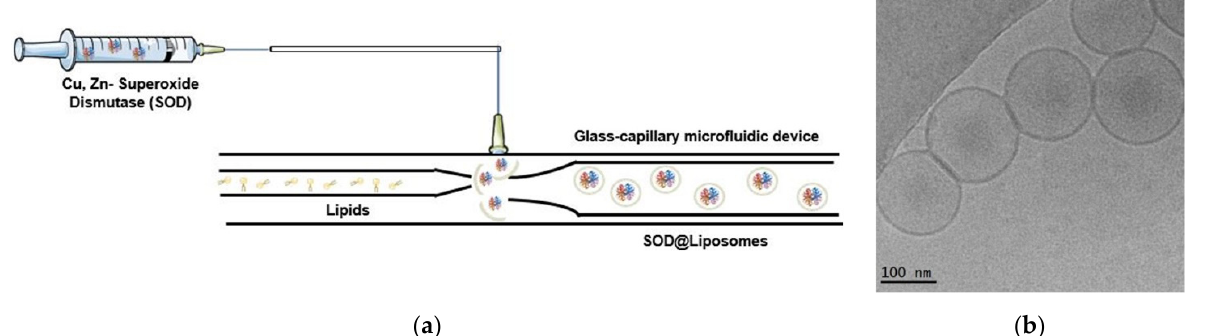
Figure 19. One-step microfluidics production of enzyme-loaded LUVs based on the “ethanol-injection method” by using a co-flow microfluidic glass capillary device, as published by Costa et al. (2021) [243]. ( a ) Schematic representation of the set-up. A borosilicate glass capillary (“inner” capillary) with an inner diameter of 100 μ m was placed coaxially in front of a “collecting” glass capillary with an inner diameter of 120 μ m. Both capillaries were inserted into an “outer” capillary with an inner diameter of 1 mm. A mixture of egg PC:cholesterol:DSPE-PEG2000 (1.85:1:0.15, molar ratio) dissolved in ethanol was injected into the “inner” capillary (“inner phase”), and an aqueous solution of the enzyme SOD (Cu,Zn-superoxide dismutase) was injected to the “outer” capillary (“outer phase”); see text and [243]. The size of the lipid vesicles obtained—SOD@Liposomes—for the experimental conditions used was 135 ± 41 nm, with efficient loading of the enzyme; see text and [243]. ( b ) Cryo TEM image of the SOD-containing vesicles obtained (bar: 100 nm) [243]. Reproduced with permission from [243], Elsevier, 2021.